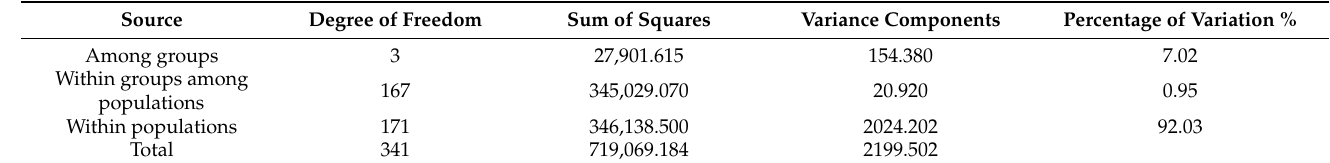
Table 3. Analysis of molecular variance (AMOVA) for four regions C. camphora .